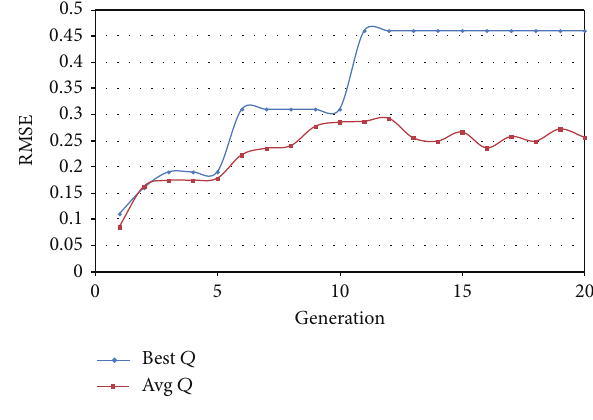
Figure 5: Result of community partition.